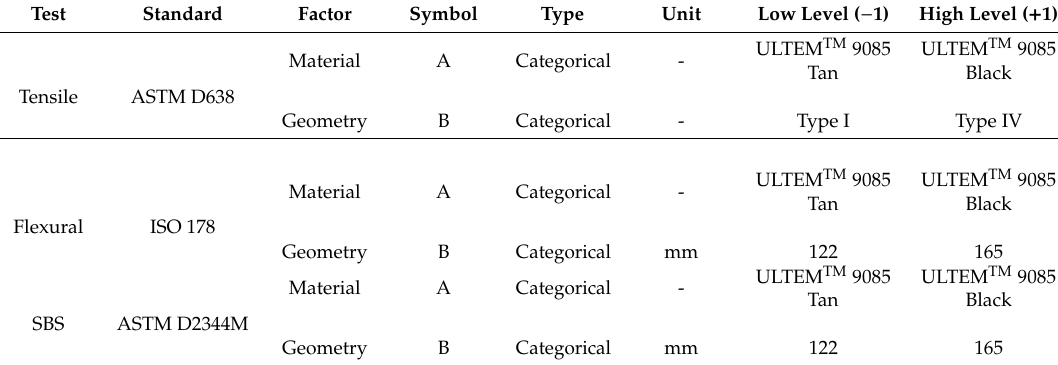
Table 1. Experimental plans. Factors, levels and responses for each investigated